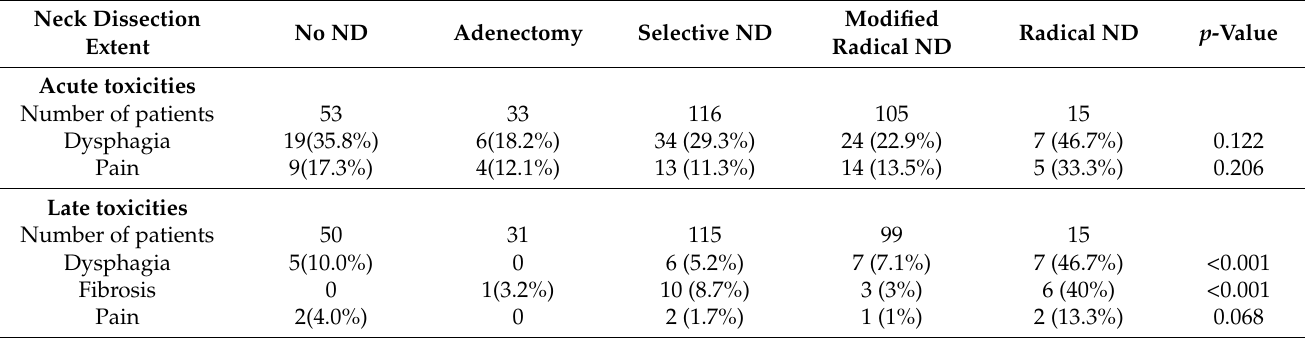
Table 4. Impact of neck dissection on grade III-IV acute and late